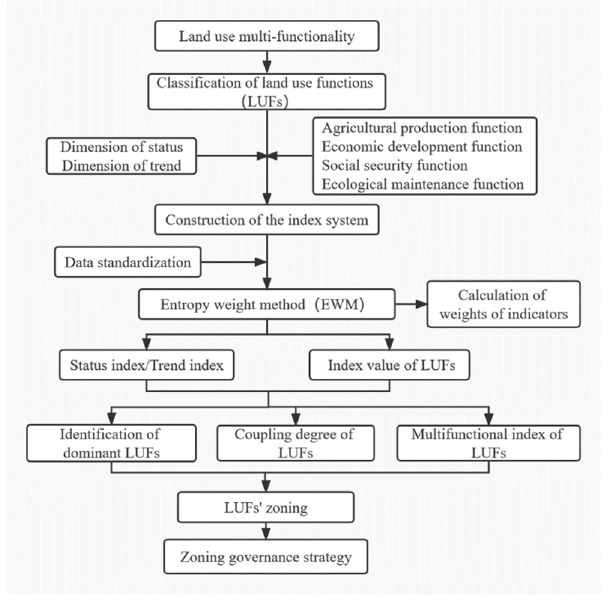
Figure 2. Analysis